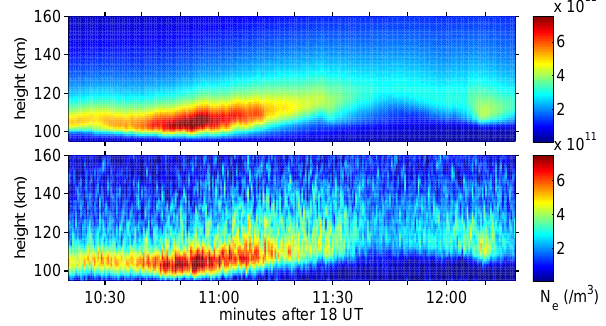
Fig. 6. Modelled (top) and measured (bottom) height profiles of electron density.